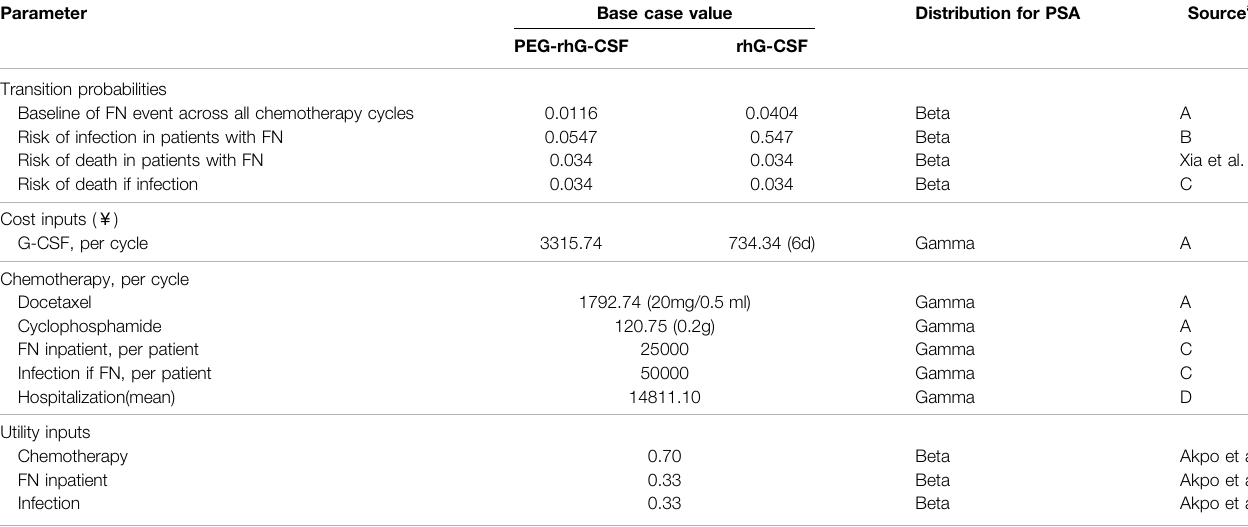
TABLE 1 | Summary of input parameters for the chemotherapy model.